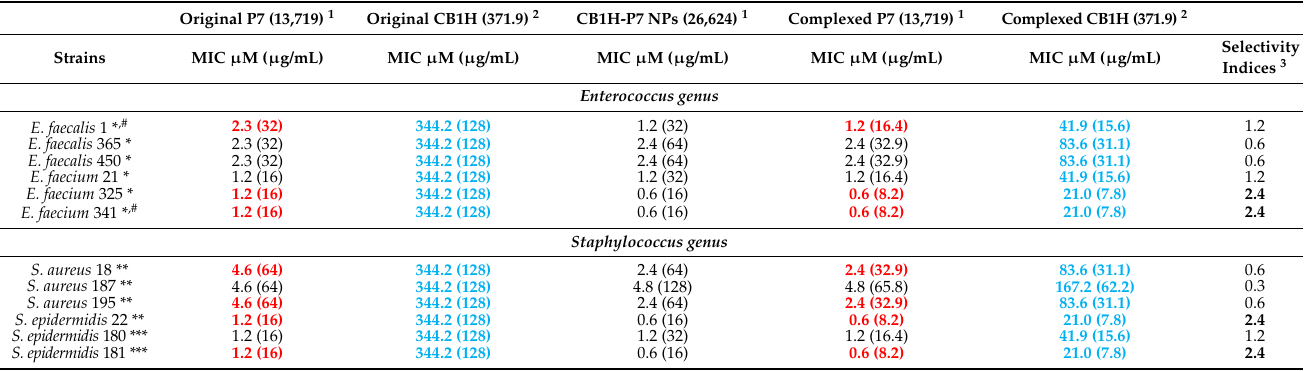
Table 3. MIC values of P7 and CB1H when administered alone, MIC values of CB1H-P7 NPs, and those of P7 and CB1H in the complex according to the (DL%) of CB1H-P7 NPs [23] against bacteria of Gram-positive species, obtained from experiments carried out at least in triplicate, expressed as µ M and µ g/mL.